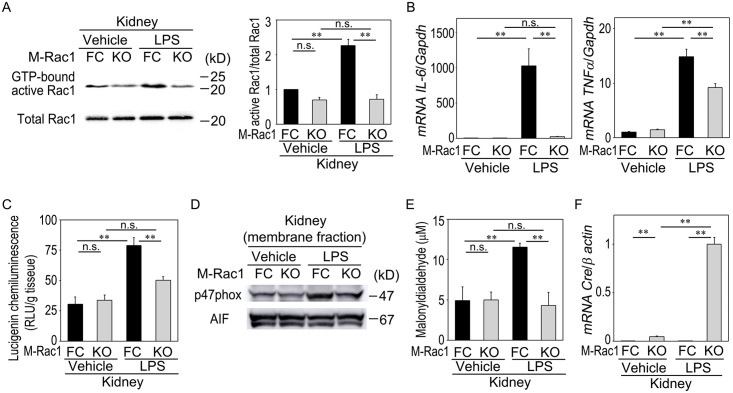
Effects of LPS injection on Rac1 activity, macrophage-related cytokine mRNA expression, NADPH oxidase activity, and ROS production in M-Rac1 FC and KO mice.(A) Expression of GTP-bound active Rac1 in the kidneys from Vehicle- or LPS-injected M-Rac1 FC and KO mice, as evaluated by GST pull-down assay. Left panel, representative blots. Right panel, result of densitometric analysis. Data are means ± s.e.m. Statistical analysis was performed by two-way ANOVA, P < 0.01 genotype effect, P < 0.01 treatment effect, P < 0.01 interaction effect. **P < 0.01 by Bonferroni's post hoc test. n = 3 per each group. (B) The mRNA levels of macrophage M1 cytokines, IL-6 and TNFα, in the kidney homogenates. Statistical analysis was performed by two-way ANOVA, P < 0.01 genotype effect, P < 0.01 treatment effect, P < 0.01 interaction effect. **P < 0.01 by Bonferroni's post hoc test. n = 8 per each group. (C) NADPH oxidase activity in the kidney was expressed as ROS generation in the presence of NADPH by the lucigenin chemiluminescence method. Statistical analysis was performed by two-way ANOVA, P < 0.01 genotype effect, P < 0.01 treatment effect, P < 0.01 interaction effect. **P < 0.01 by Bonferroni's post hoc test. n = 5 per each group. (D) Representative immunoblot of p47phox in the membrane fraction of the kidney. AIF was used as a loading control. (E) ROS in the kidney homogenates were measured as malonyldialdehyde using TBARS Assay Kit. Statistical analysis was performed by two-way ANOVA, P < 0.01 genotype effect, P < 0.05 treatment effect, P < 0.01 interaction effect. **P < 0.01 by Bonferroni's post hoc test. n = 4 per each group. (F) Expression of cre mRNA in the kidneys from Vehicle- or LPS-injected M-Rac1 FC and KO mice. Statistical analysis was performed by two-way ANOVA, P < 0.01 genotype effect, P < 0.01 treatment effect, P < 0.01 interaction effect. **P < 0.01 by Bonferroni's post hoc test. n = 5 per each group.